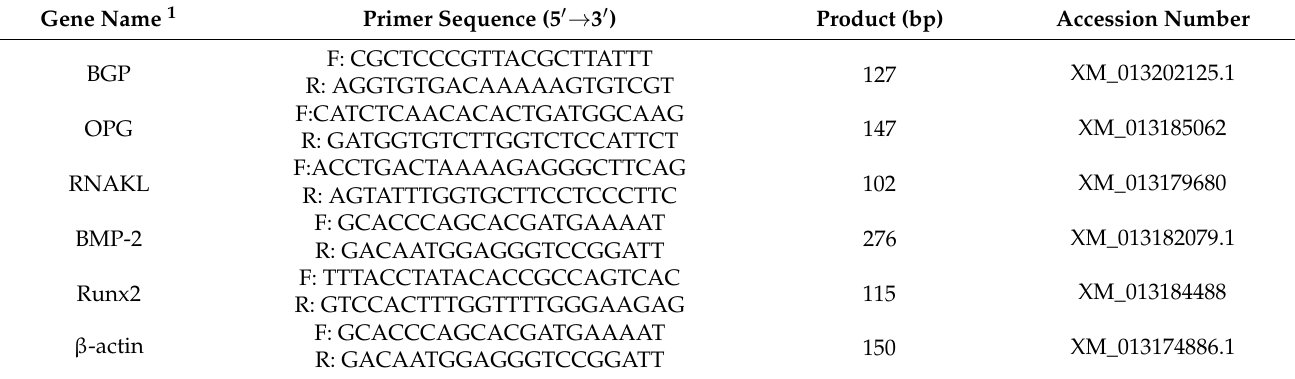
Table 2. Gene primers’